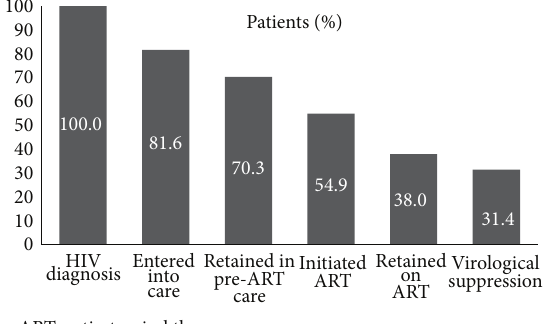
Figure 3: Cumulative retention of patients at each stage of care after HIV diagnosis.